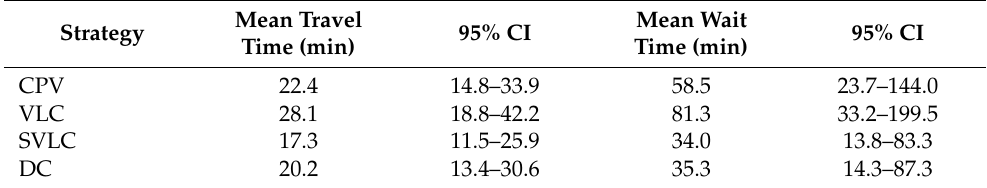
Table 6. Average time spent by dog owners at the central point and time taken to reach the cen- tral